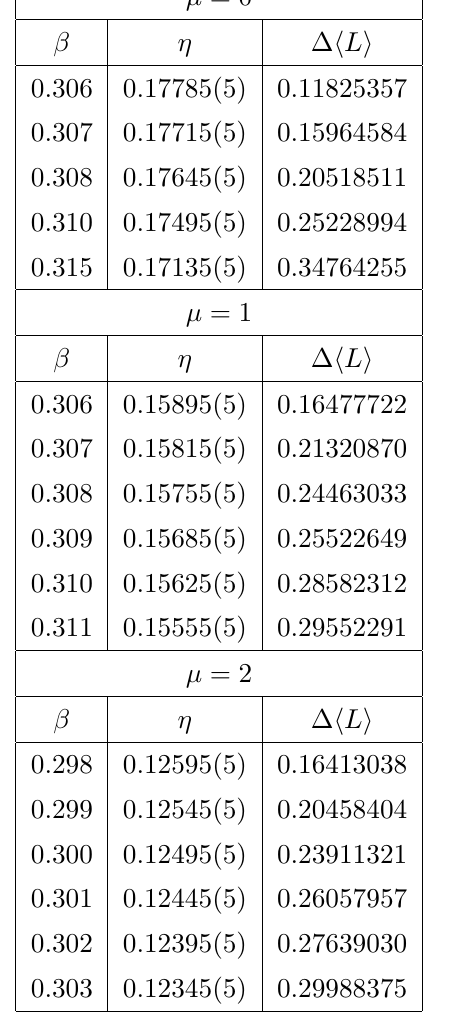
Table 3 . ∆ h L i and the first-order transition points ( β, η ) at µ = 0 , 1 , 2 . All the results are obtained with D = 48 in the TRG